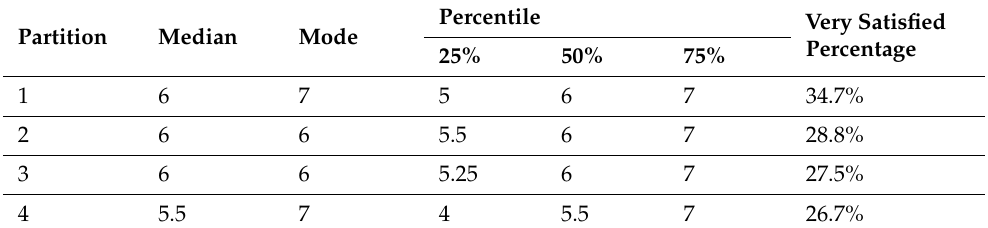
Table 6. Sky landscape data statistics.